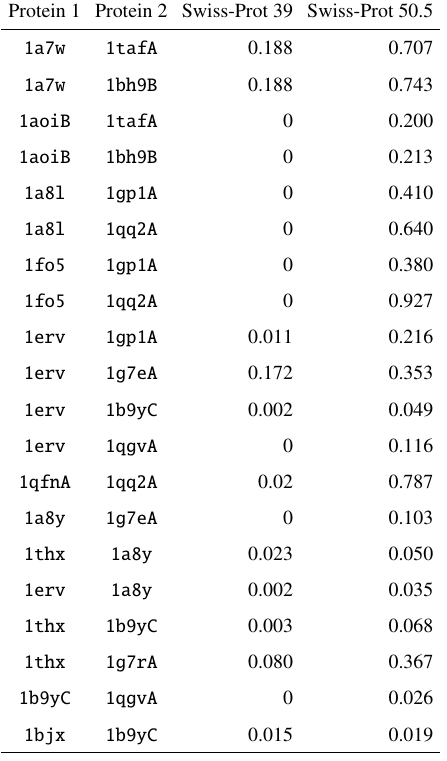
Table 3: Keyword overlap scores for 20 homologous protein pairs that were misclassified using this feature